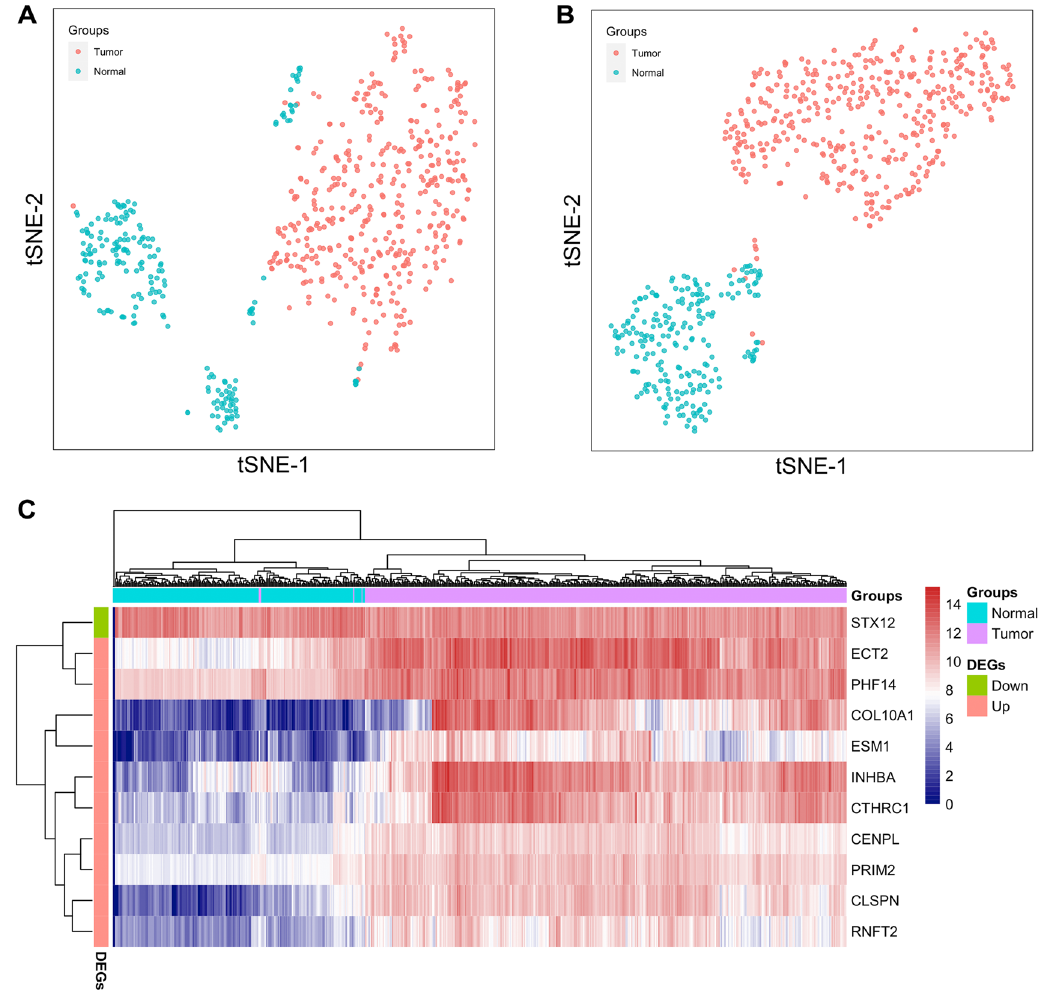
Figure 3. Classification of STAD tumor and normal groups. ( A, B ) T-SNE plots displayed the distribution of tumor and normal samples based on the 8,863 DEGs and the 11 candidate genes, respectively. ( C ) Bi-clustering heatmap of the 11 candidate genes and all 623 samples. DEGs: differentially expressed